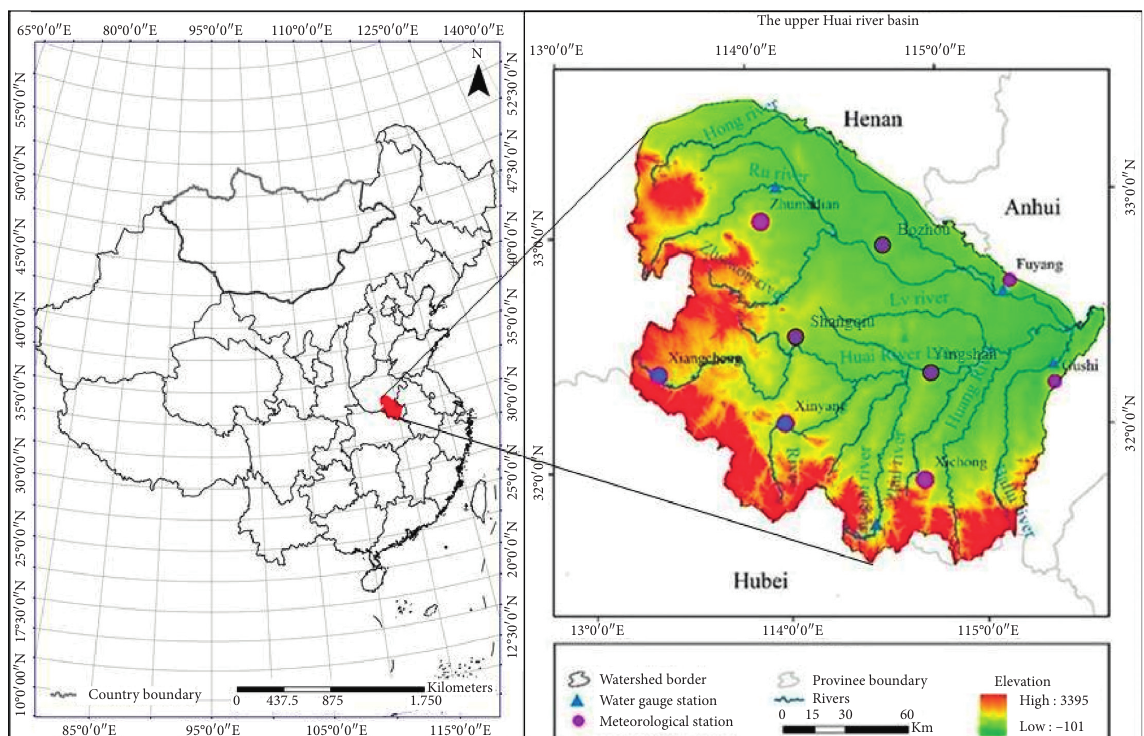
Figure 1: Locations map of the study